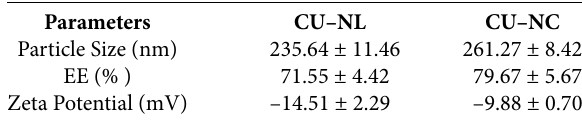
Table 6. Characterization of CU–NL and CU–NC